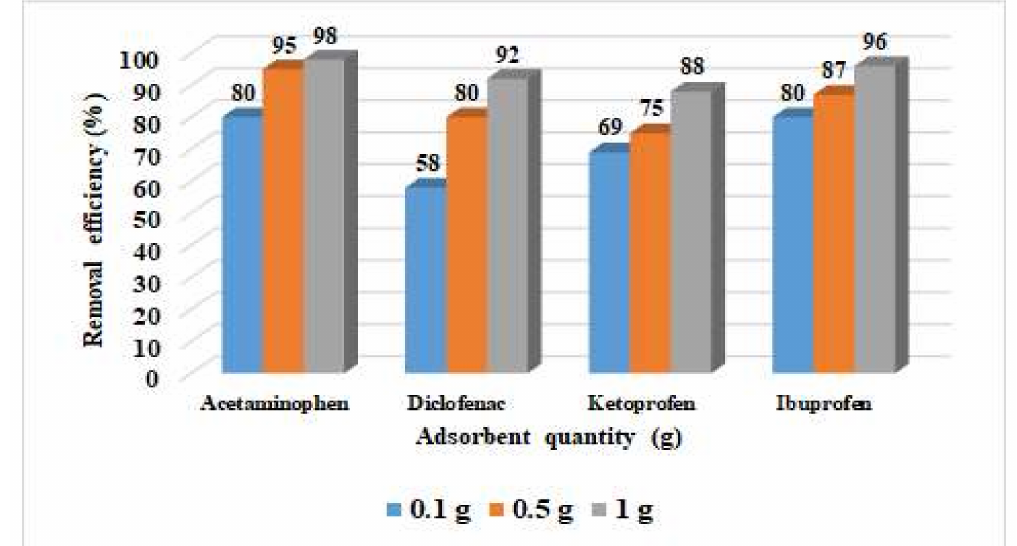
Figure 2. Removal efficiency versus adsorbent quantity. The linear profile of the Langmuir isotherm was obtained by graphical representation of the Ce/Qe ratio versus Ce in Figure